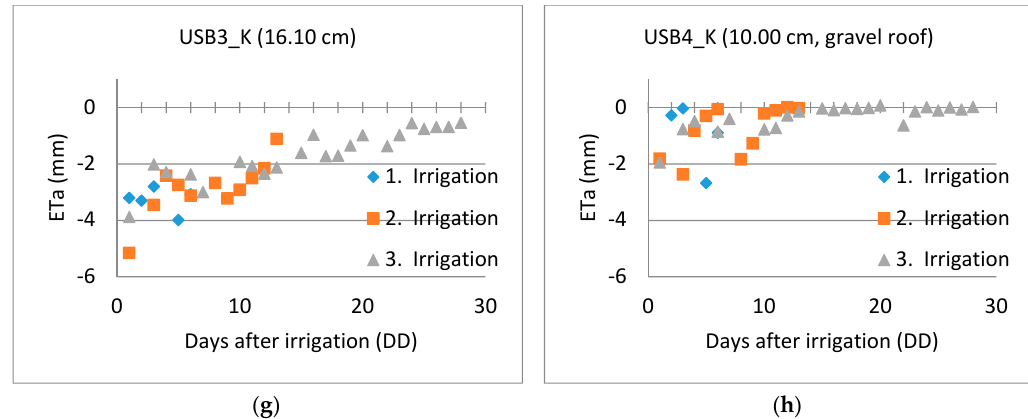
Figure 8. ( a–h ). Decrease in the daily ET a after the three irrigation periods. Systems with higher substrate and/or insulation levels will have a longer ET a over time. ( a ) USB1_O = EGR with 8.88 cm